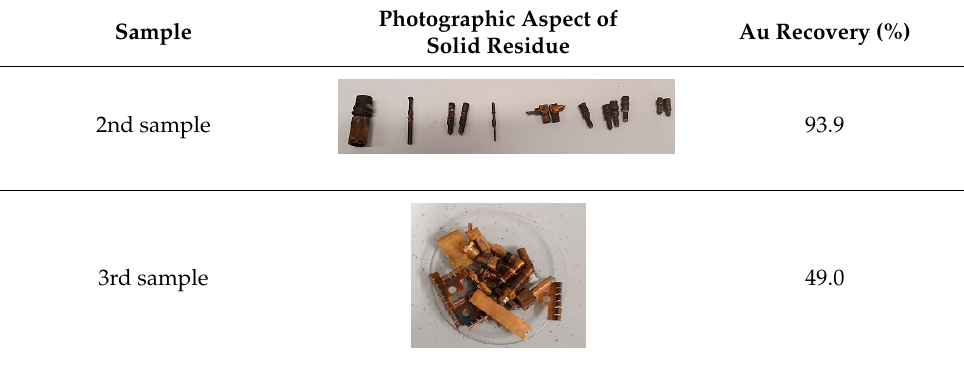
Table 3. Gold and silver cumulative dissolution yields as a function of stage number.